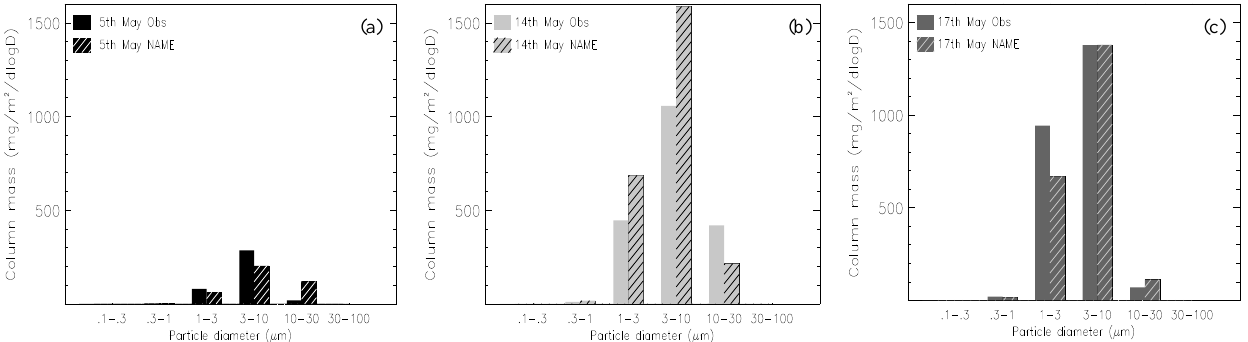
Fig. 6. Re-binned observed column integrated mass (solid fill) and NAME column integrated mass (striped fill) using distal particle size distribution 2. (a) 12 UTC on 5th May, (b) 13 UTC on 14th May and (c) 15 UTC on 17th May.